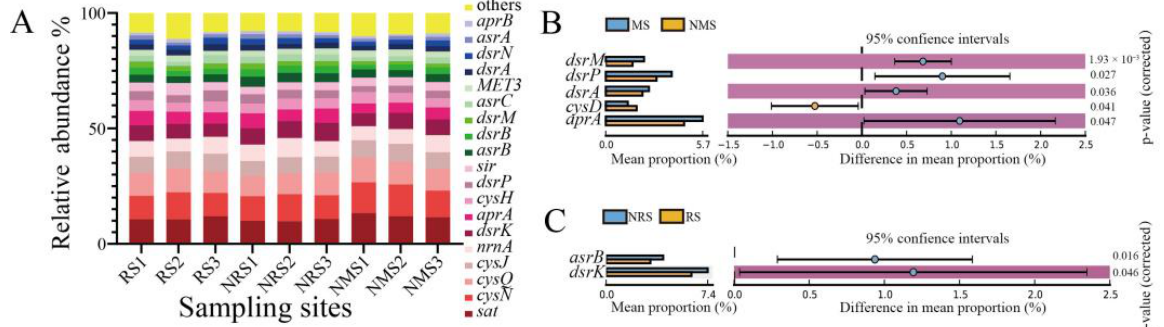
Figure 4. ( A ) Bar chart of the relative abundance values of 20 abundant dissimilatory sulfate-reducing gene (sub)families in each sample. Significant differences in sulfur gene (sub)families ( B ) between mangrove and non-mangrove sediments and ( C ) between rhizosphere and non-rhizosphere sediments.